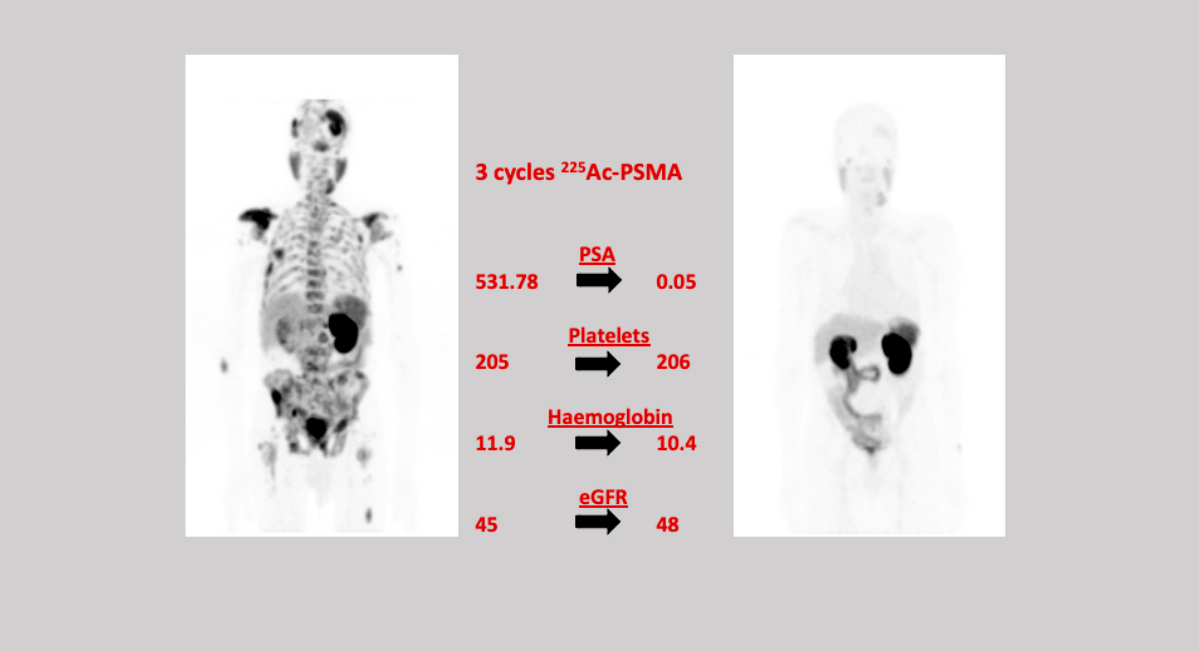
Figure 3. A 79 yr old male with prostate adenocarcinoma. Gleason score = 4 + 3. Previous therapy—prostatectomy. 68 Ga- PSMA-617 demonstrated widespread axial and appendicular skeletal metastases. He received three cycles of 225 Ac-PSMA therapy (19 July 2017, 28 September 2017 and 23 November 2017). The patient had an excellent biochemical, clinical, and imaging response and was in remission.